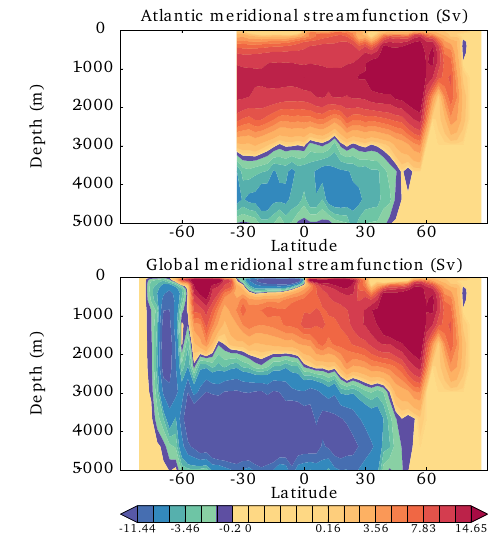
Figure 8. Atlantic and global meridional streamfunction